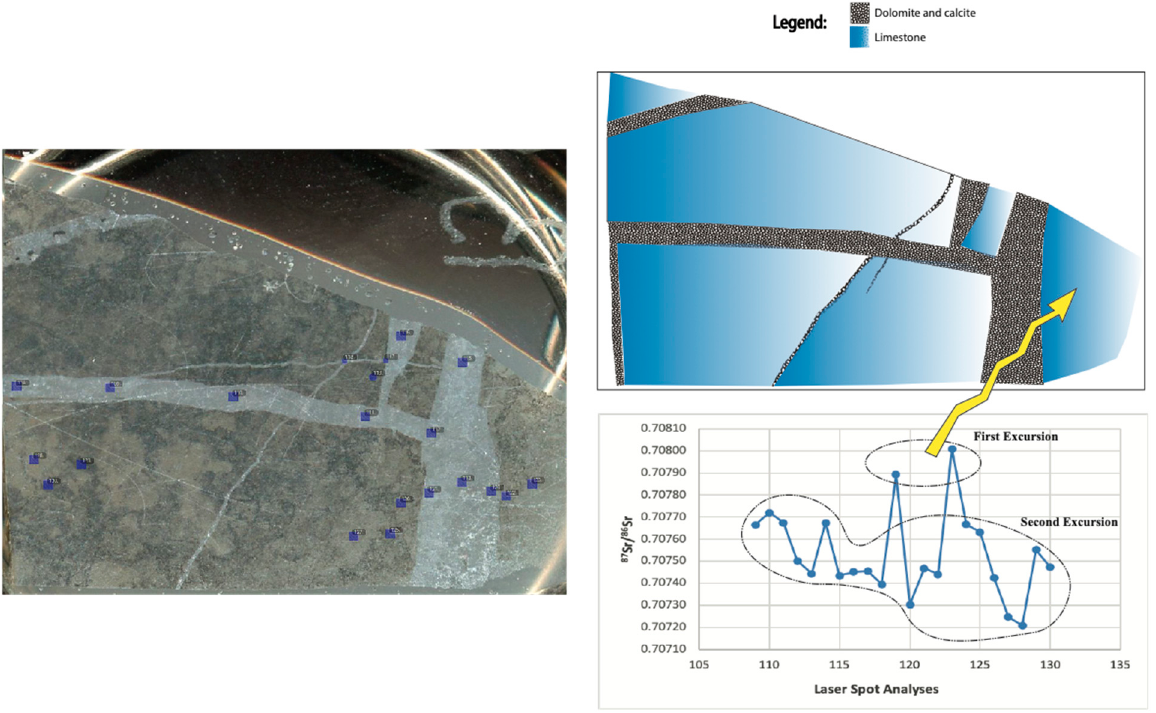
Figure 11. The absolute radiogenic strontium isotope values v. the location of the spot analysis “Sample No. B9”. The location of analysis is represented by cubic blue color where the ablated spot size used is 213 µm and depth of crater is ~20 µm.